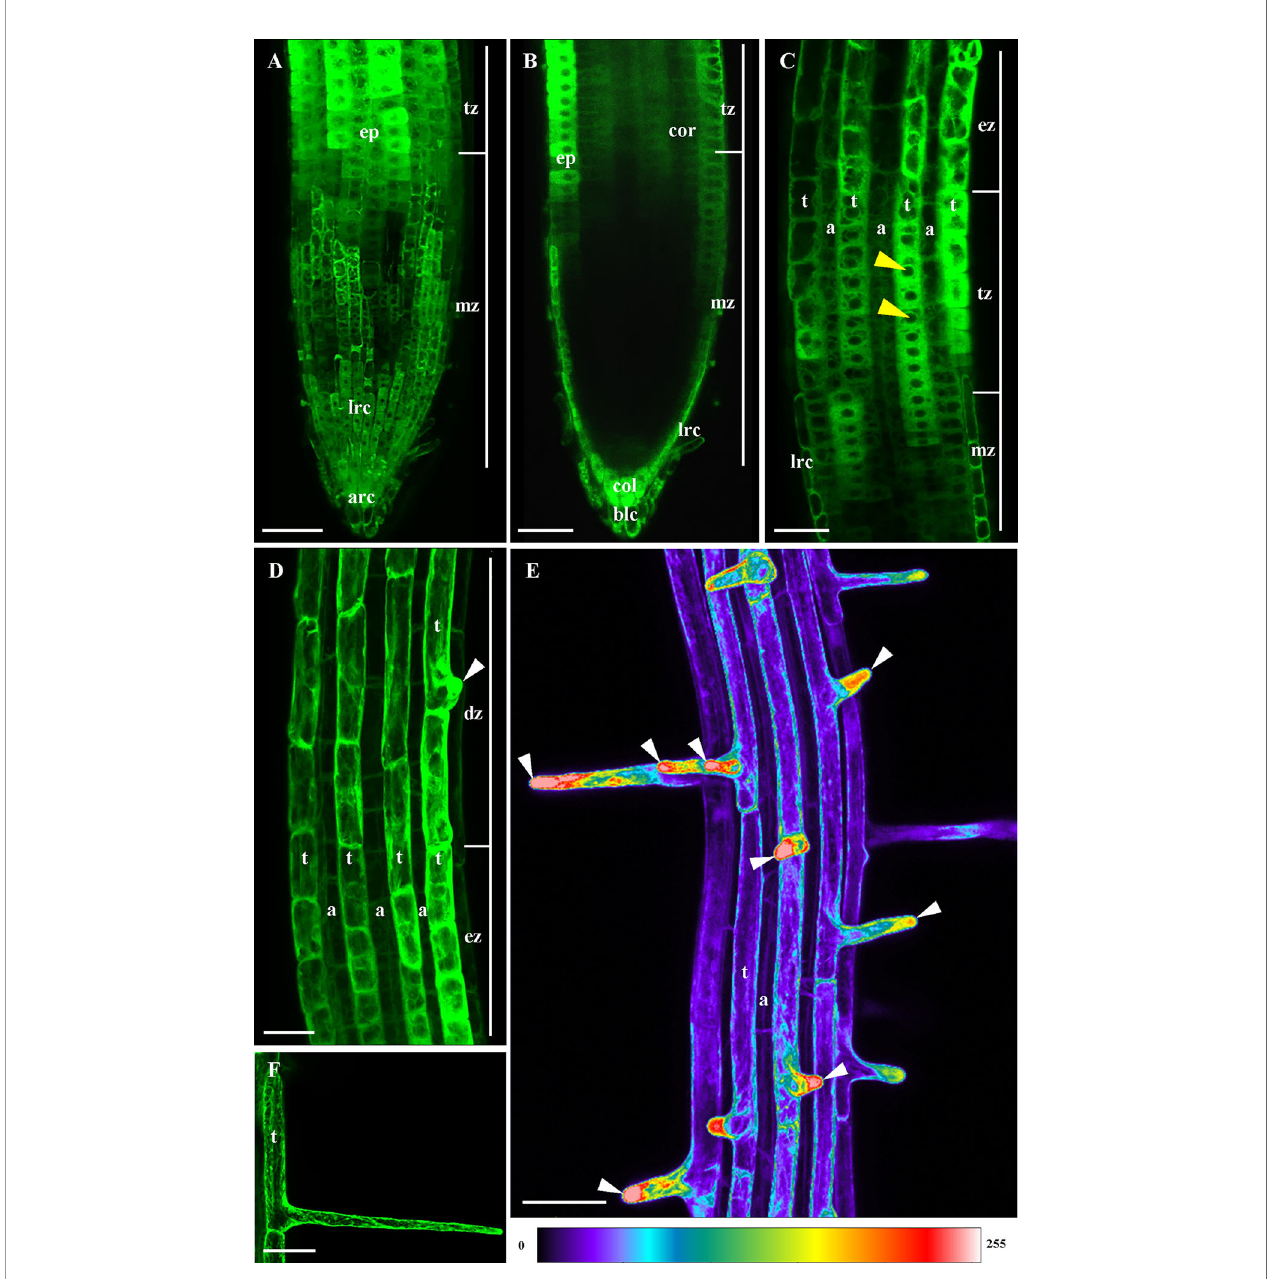
FIGURE 2 | Localization of ANN1-GFP in the primary root of A. thaliana stably expressing proANN1::ANN1:GFP construct using CLSM. (A) Maximum intensity projection and (B) medial optical section overview of ANN1-GFP localization in the root apex. In the meristematic zone (mz) the expression level is very low. ANN1- GFP starts to be detectable in root epidermis (ep) within the distal portion of the meristematic zone (mz) and in the transition zone (tz), where ANN1-GFP signal appears also in deeper root tissues. (A) Relatively high expression level of ANN1-GFP is present in apical root cap cells (arc) and lateral root cap cells (lrc). (B) Apparent accumulation of ANN1-GFP is also in border-like cells (blc) and the apical layer of columella (col) in medial plane of the root. (C, D) A striped-like pattern of ANN1-GFP expression in root epidermis within the elongation (C) and differentiation zone (D) of the root. A pattern of higher expression in trichoblasts (t) and lower expression in atrichoblasts (a) is preserved from the end of meristematic zone (mz) through the transition zone (tz) to the elongation zone (ez). The abundance of ANN1-GFP in trichoblast cell fi les is enhanced before and during the root hair initiation within the differentiation zone (dz), when ANN1-GFP is accumulated in the bulge and emerging root hair tip [arrowhead in (D) ]. Note the absence of ANN1-GFP fl uorescence in nuclei of trichoblasts indicated by yellow arrowheads in (C) . (E) A color-coded image representing maximum intensity projection from individual Z-stacks of root differentiation zone with moderate fl uorescence signal in trichoblast cell fi les (t), high fl uorescence signal in emerging and growing root hairs, whereas low signal was observed in atrichoblast cell fi les (a). Note the tip-focused accumulation of ANN1-GFP in emerging and actively-growing root hairs indicated by arrowheads. (F) Typical net-like distribution of ANN1-GFP in cortical layers of cytoplasm in the trichoblast (t) and fully-grown root hair. Scale bars = 50 m